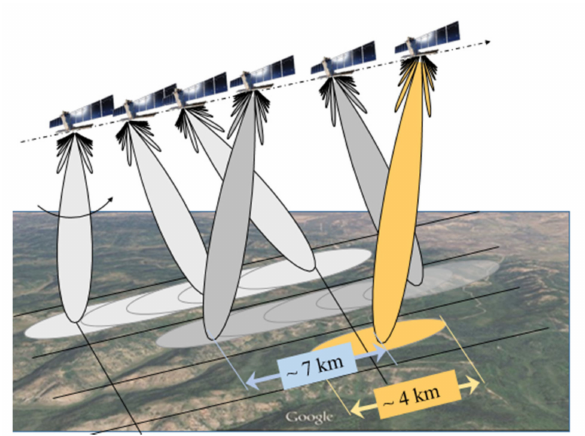
Figure 1. Sketch of TOPSAR acquisition mode, here represented as the three swaths Sentinel-1 IW.